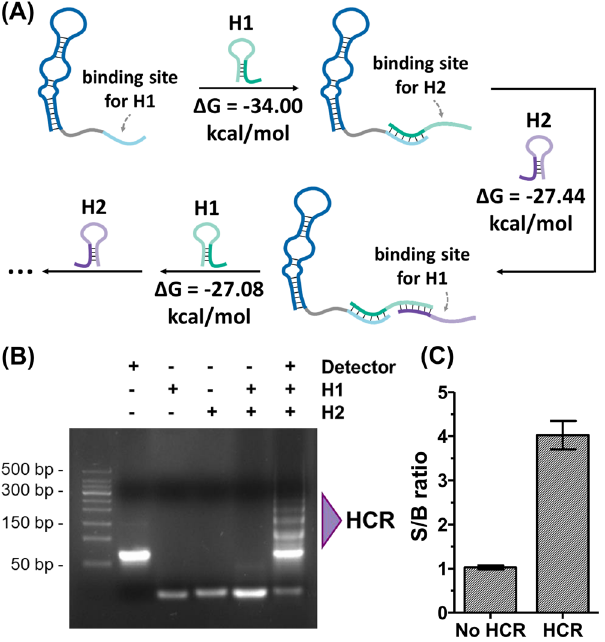
Figure 3. Establishment and effect of aptamer-mediated HCR. ( A ) Schematic description of aptamer-mediated HCR. Calculated Gibbs free energies of hybridization between trigger, H1 and H2 suggested the accessibility of the HCR. ( B ) Confirmation of HCR by gel electrophoresis analysis. Lane 1: T&I 50 bp DNA ladder. Lane 2–4: detector, H1, and H2, respectively. Lane 5: mixture of H1 and H2 (H1 + H2). The hairpins did not hybridize without detector. Land 6: hairpins with detector (H1 + H2 + detector). HCR occurred when all of the reagents existed, with multiple bands representing the HCR products. The original gel is presented in Fig. S4. ( C ) Signal amplification by HCR on the ELONA in response to 10 nM of EN2; the S/B without HCR was 1.03 ± 0.05, whereas the S/B with HCR was 4.00 ± 0.68 (not great, but > 3 ×). Bars: ± s.d., n = 3.